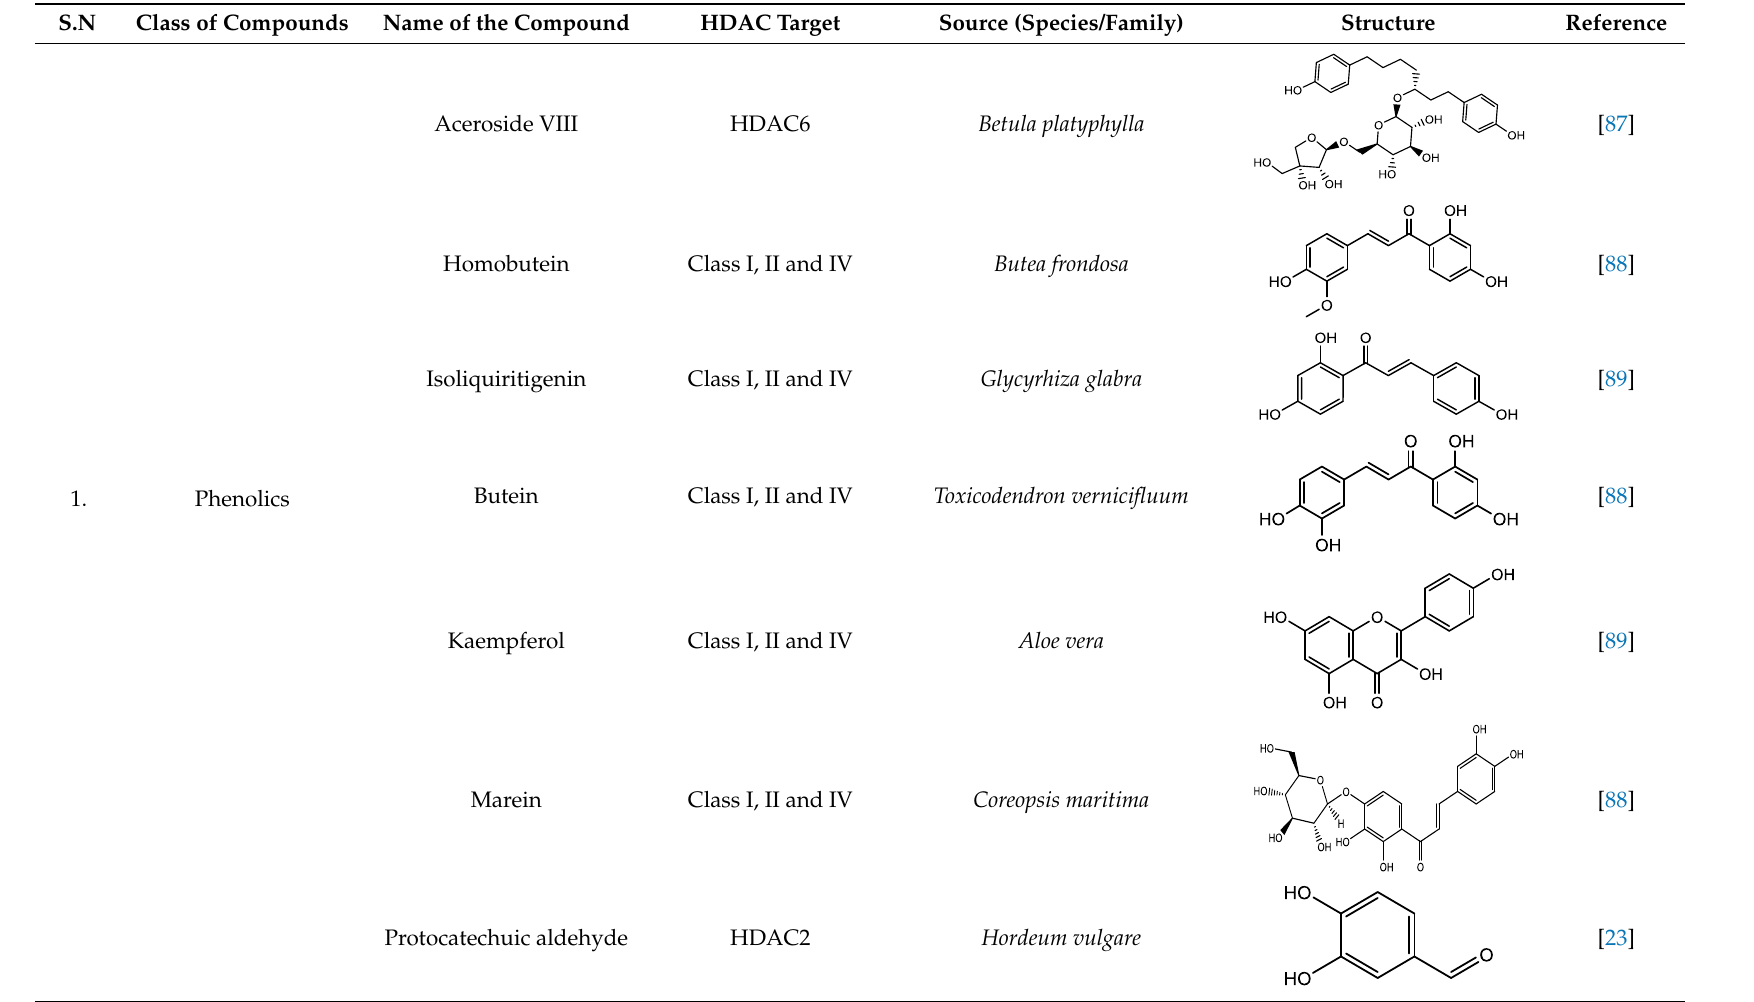
Table 2. Examples of the natural compound with histone deacetylase inhibitory activity.